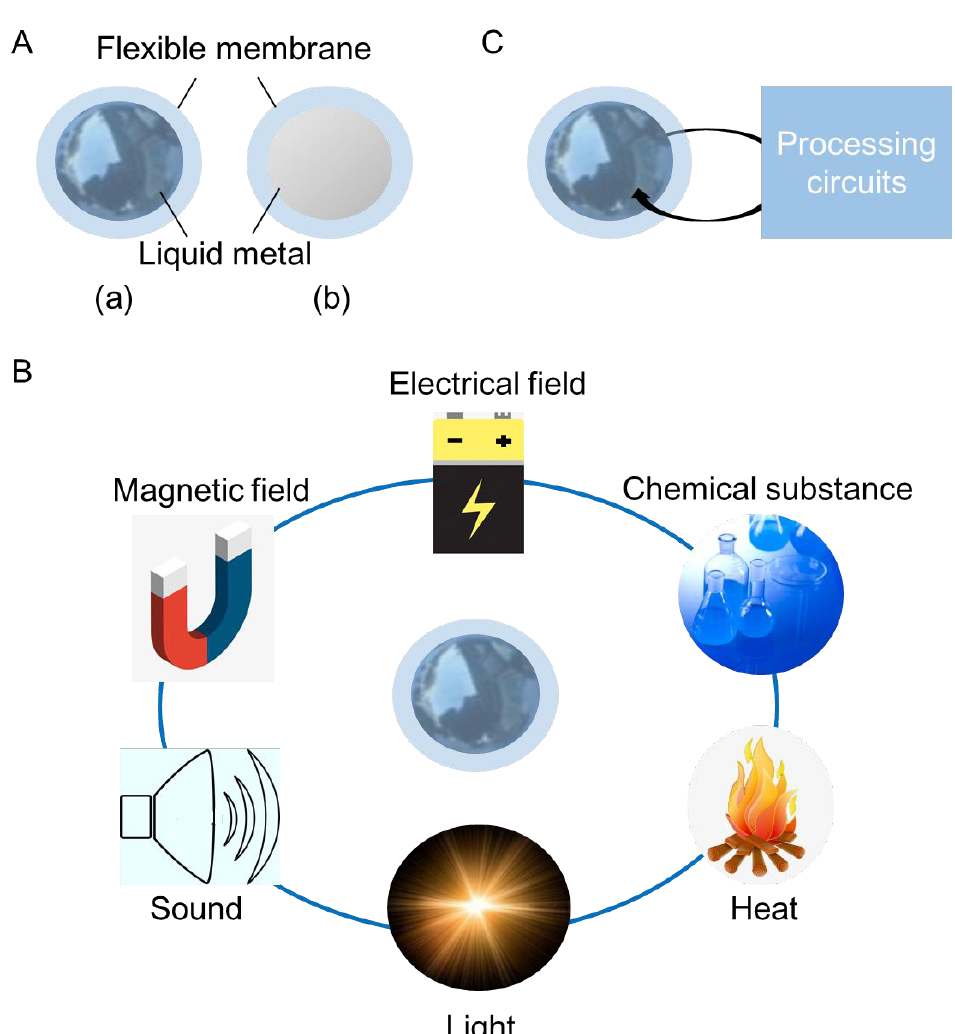
Figure 12. Metal-enabled liquid sensors. ( A ) Illustration of liquid sensor: ( a ) Front view; ( b ) Sectional view. ( B ) Working principle of liquid sensor. ( C ) Diagram of a liquid sensor system.